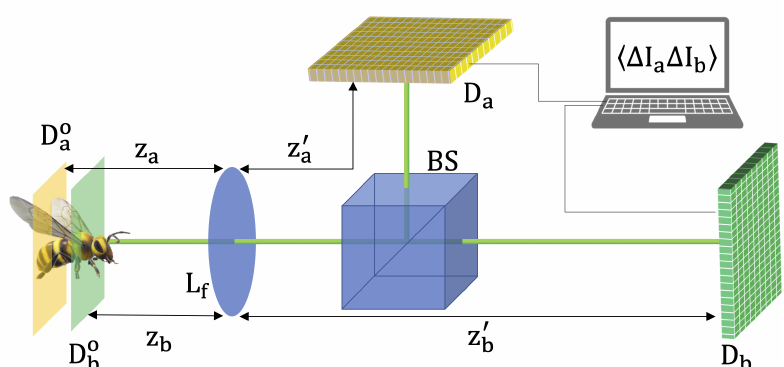
Figure 1. Representation of a setup for correlation plenoptic imaging between arbitrary planes (CPI- AP); the object is supposed to be a chaotic light emitter [30]. The lens L f focuses the images of the two planes D o a and D o on the two spatially resolving sensors D a and D b , respectively. By correlating b the intensity fluctuations retrieved by each pair of pixels on the two detectors, information on the distribution and direction of light from the object is